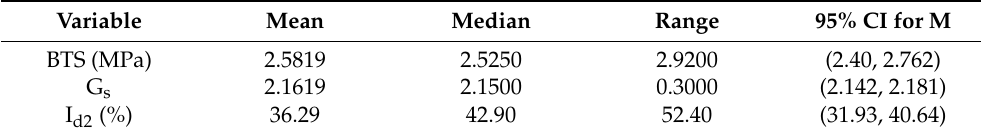
Figure 3. Probability plot of the BTS. Table 2. Descriptive statistics of the BTS.